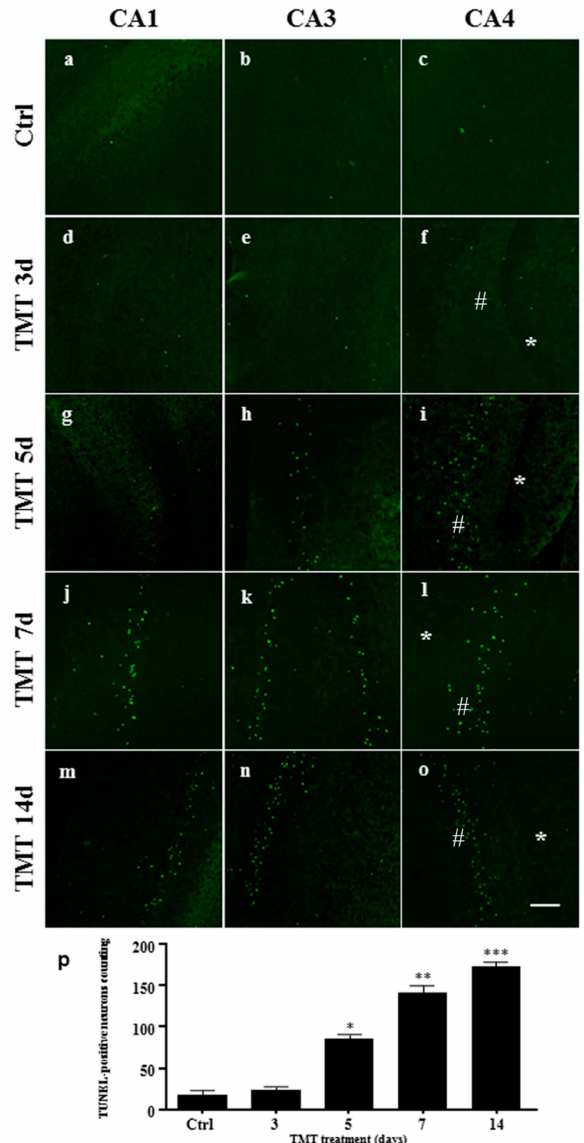
Figure 5. An increased number of apoptotic nuclei in the rat hippocampus after TMT treatment is shown. Representative confocal images of the CA1, CA3, and CA4 (#) areas from the hippocampus of control rats ( a – c ) and rats treated with TMT for 3 ( d – f ), 5 ( g – i ), 7 ( j – l ), and 14 ( m – o ) days, stained for the presence of apoptotic nuclei (TUNEL staining, green). No apoptotic cells were observed in the Dentate Gyrus (*) at any time of treatment ( f , i , l , o ). Scale bar: 100 µ m. Ctrl: control sample, d: days. For interpretation of the references to color in this figure legend, the reader is referred to the Web version of this article. ( p ) The number of TUNEL-positive nuclei. The number of apoptotic nuclei increased gradually and significantly in all the hippocampal areas starting from 5 up to 14 days post treatment. Values are presented as mean ± SEM for each group: the control rats ( n = 3) and 3, 5, 7, and 14 days TMT-treated rats ( n = 3 / group), * p < 0.05, ** p < 0.01, *** p < 0.001 compared with controls, Dunnett’s